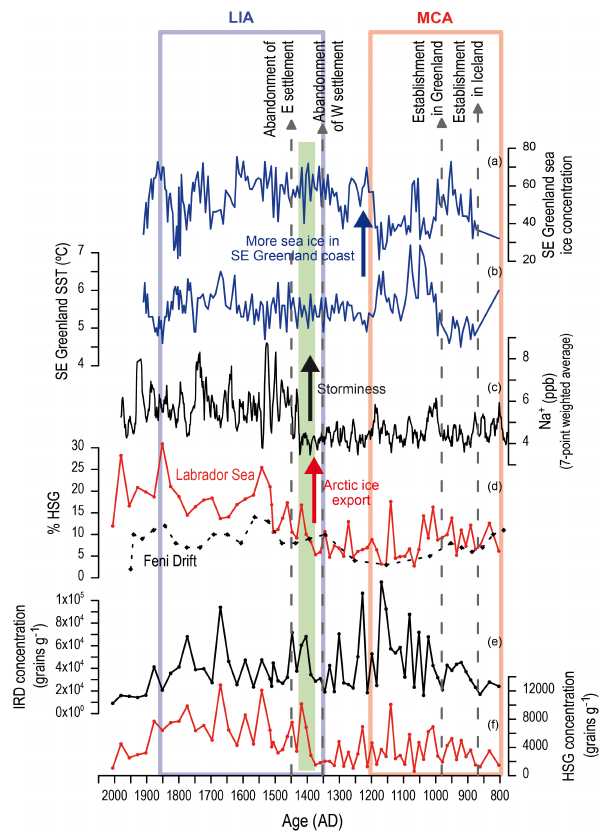
Figure 3. LIA shift at ∼ AD1400 (green vertical bar) in sev- eral records compared to site GS06-144-03 IRD records. (a) SE Greenland April sea ice concentration (Miettinen et al., 2015); (b) SE Greenland April sea surface temperature (Miettinen et al., 2015); (c) Na + record from GISP2 (Meeker and Mayewski, 2002); (d) HSG record from Eirik Drift (red line) and from Feni Drift in the NE Atlantic (black dashed line; Bond et al., 2001); (e) total IRD concentration; and (f) HSG concentration. The main events in Norse colonization and abandonment of settlements are depicted at the top of the figure, according to Ogilvie et al.